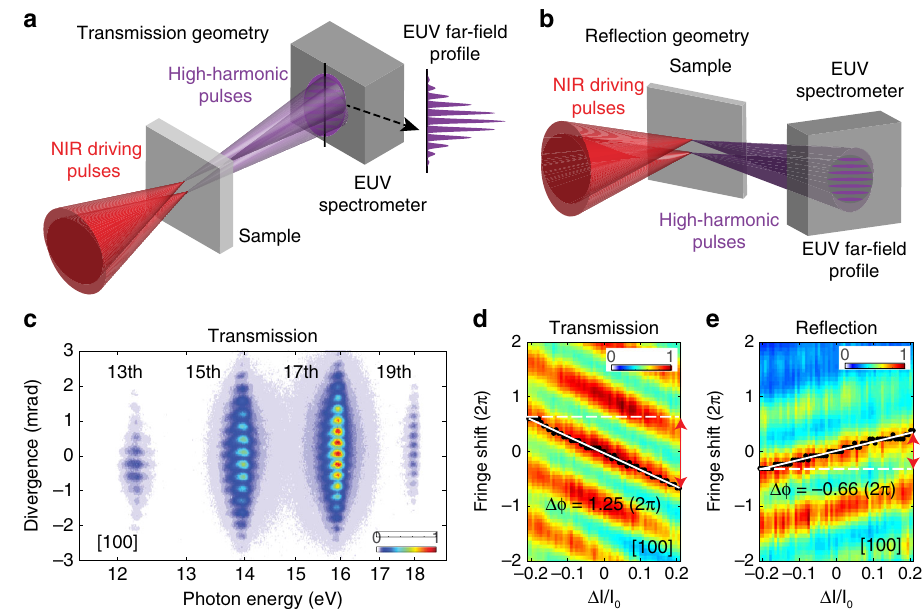
Fig. 7 Attosecond interferometry in transmission and re fl ection con fi guration. Experimental setup in a transmission and b re fl ection, where high harmonics from two sources interfere in the far fi eld. Reproduced with permission from ref. 106 , Copyright 2019, Springer Nature. A representative interferogram is shown in c . Fringe shift as a function of relative change in laser intensities, in transmission. d and in re fl ection ( e ). Re fl ection geometry closely represents the microscopic effects. Fringe shifts in transmission are overwhelmed by propagation effects. Adapted with permission from ref. 106 , Copyright 2019, Springer